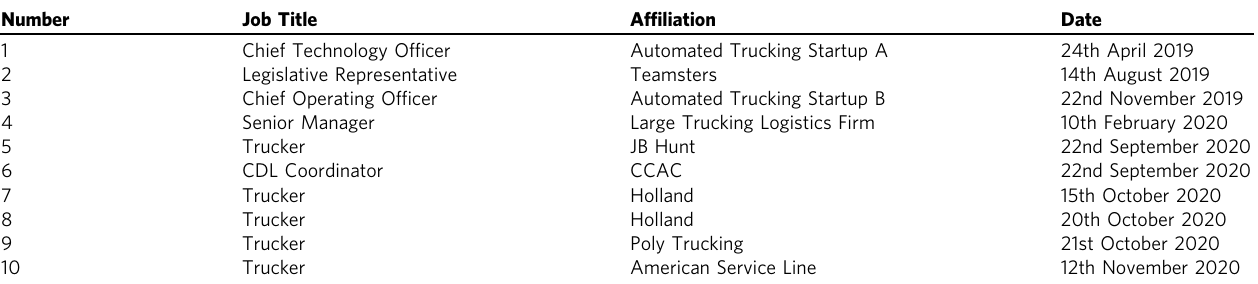
Table 2 List of interviewees.